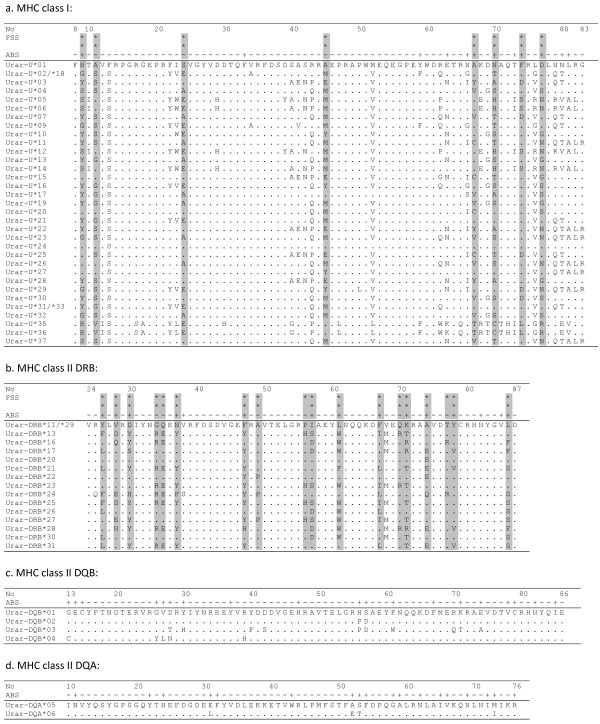
Amino acid sequences of MHC alleles in the Scandinavian brown bear. Positions in the alignment correspond to Human Leukocyte Antigen (HLA, after Reche & Reinherz, 2003). Dots mark identity to the reference sequence. The putative Antigen Binding Sites consensus positions (HLA-A, HLA-B and HLA-C for MHC class I 2nd exon alleles, HLA-DRβ for MHC class II DRB 2nd exon, HLA-DQα for MHC class II DQA 2nd exon and HLA-DQβ for MHC class II DQB 2nd exon; after Reche & Reinherz, 2003) are marked with ‘+’. Positively selected amino acid sites identified by the Bayes empirical Bayes procedure are shaded (** - posterior probability > 99%, * - posterior probability >95%).